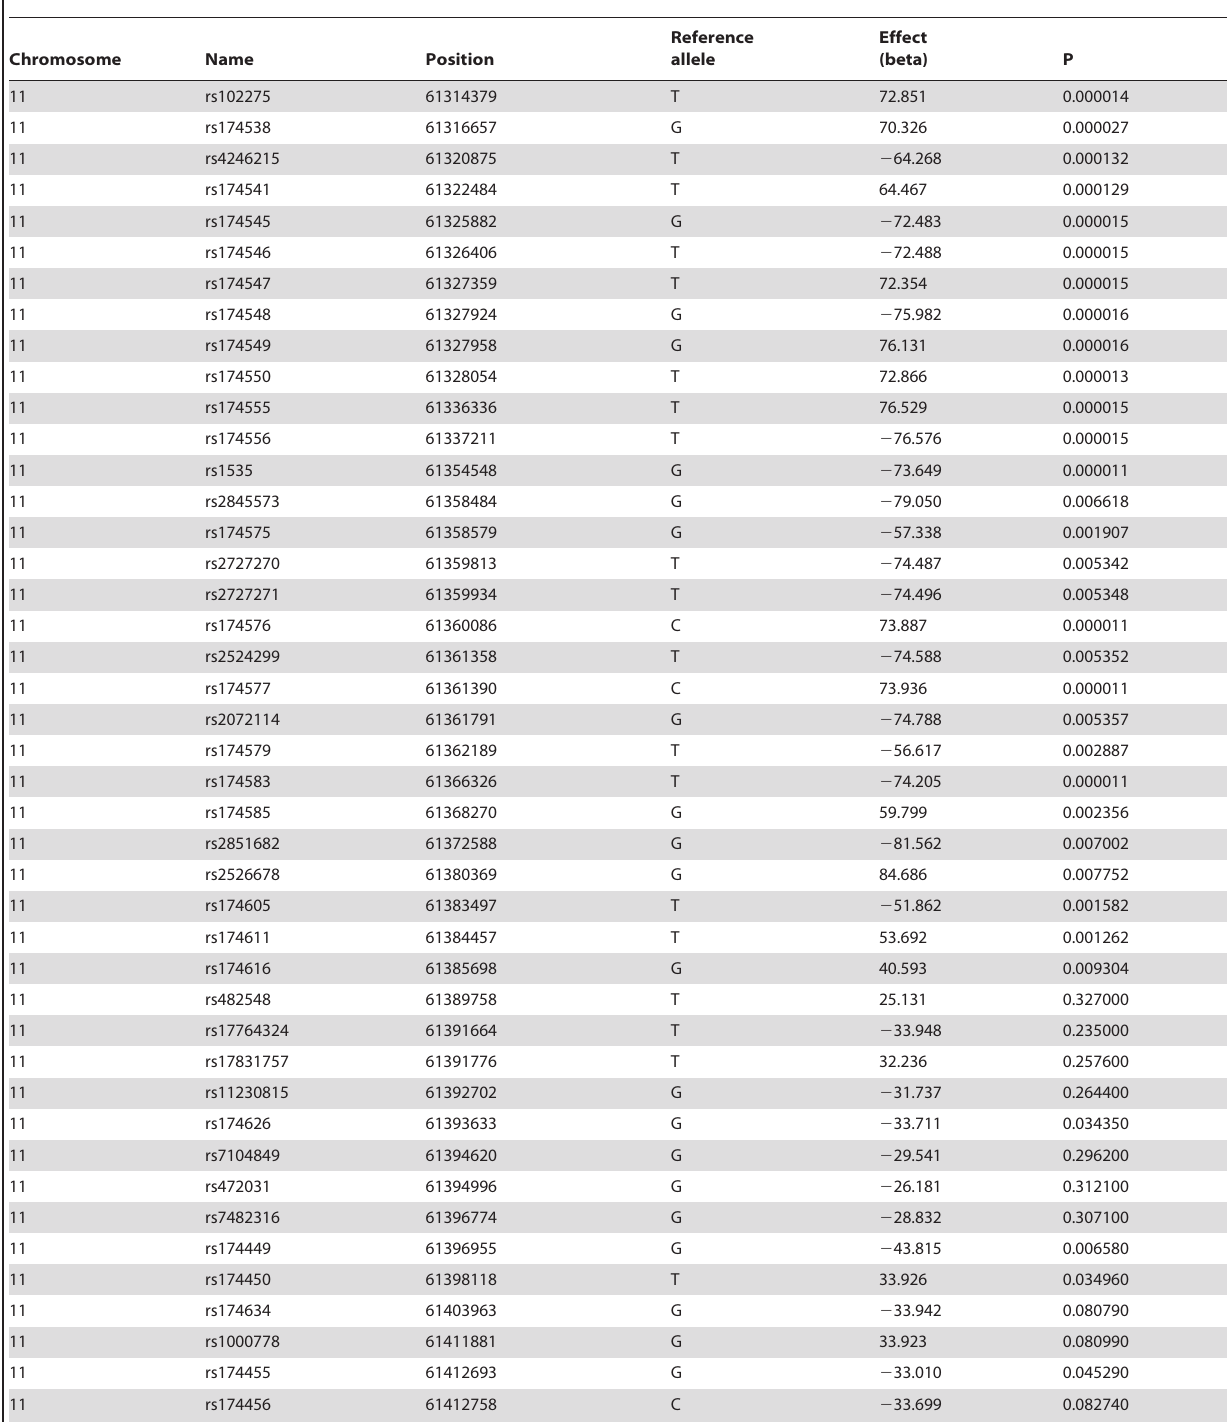
Table 4. Association of all genetic variants present in FADS clusters region and FADS1 human brain expression.